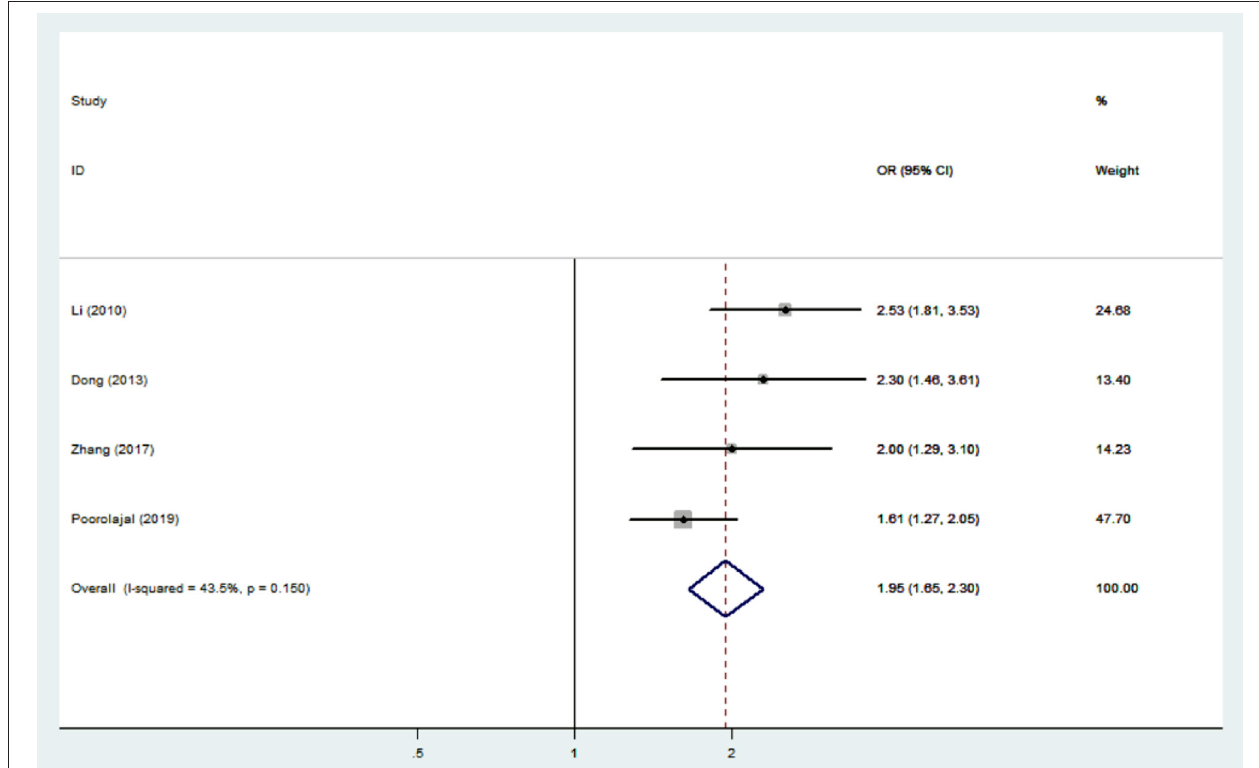
FIGURE 5 | Effect of IAD on suicidal behavior